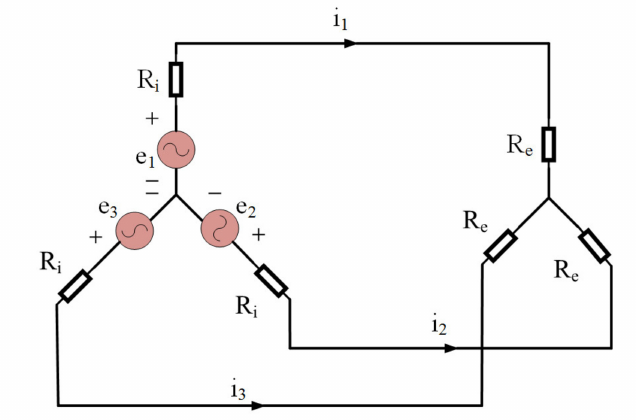
Figure 6. DC brushless motor connected to the simplified charging